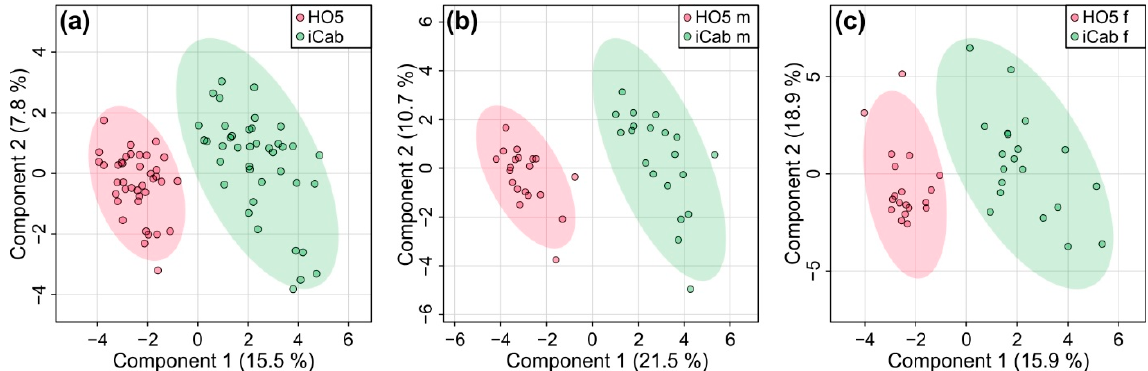
Figure 3. Partial least squares-discriminant analysis for discriminating the inbred strains HO5 and iCab ( a ) for male and female fish together and separated into ( b ) male and ( c ) female fish. Table 1. Top 15 metabolites contributing to the variance between HO5 and iCab according to PLS-DA and FC analysis. Analyses were performed separately for male and female fish, as well as with both sexes together. Only metabolite buckets are shown that had VIP values > 1.2 and FC > 1.3 or <0.77 for at least one of the different groups. For each FC, the associated FDR-adjusted p -value is